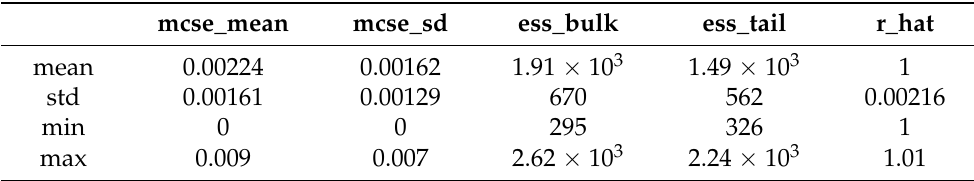
Figure 10. Posterior trace for surfaces model. Table 5. Convergence results for surfaces